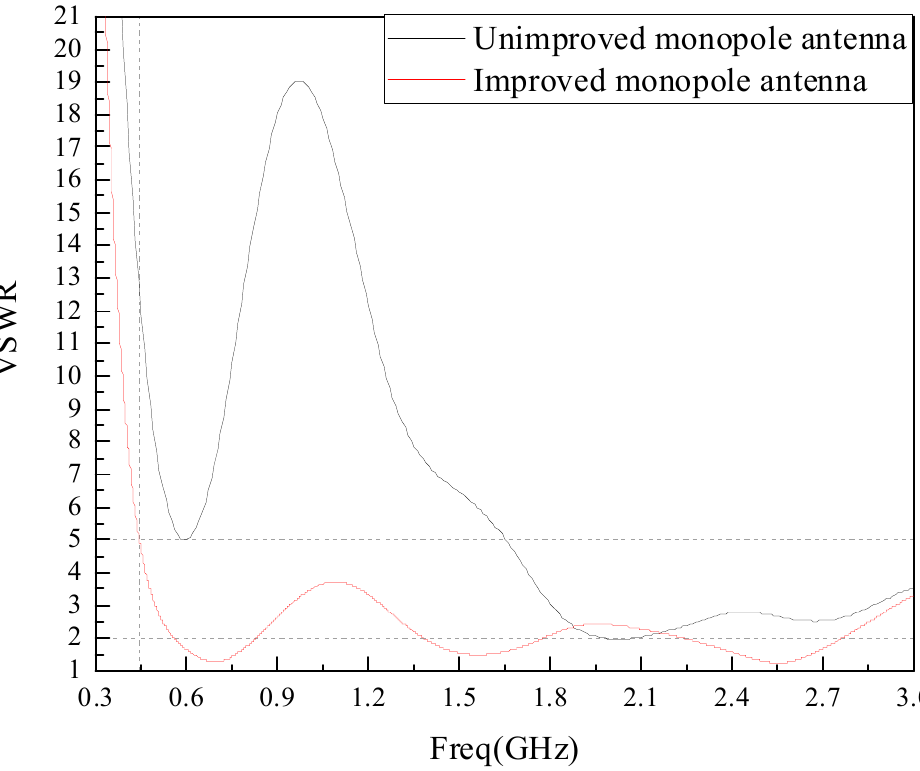
Figure 7. Antenna VSWR before and after improvement.